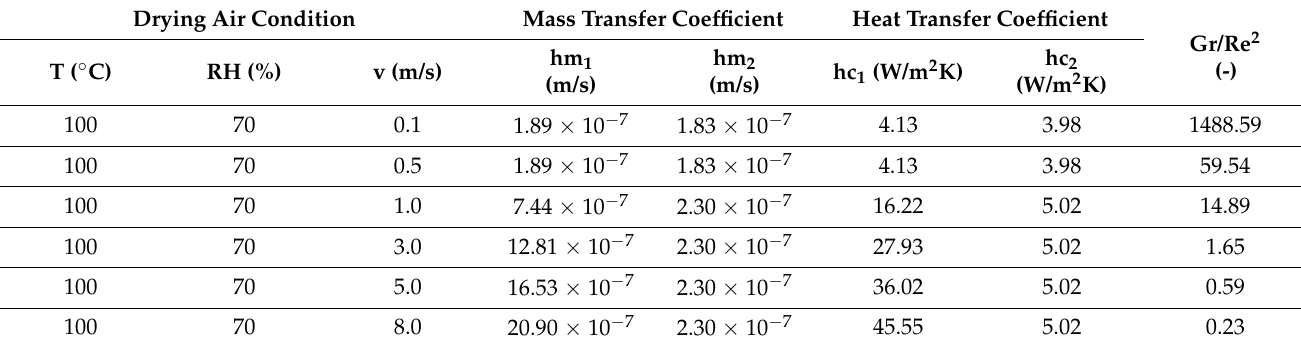
Table 8. Convective heat and mass transfer coefficients for different drying air speeds.